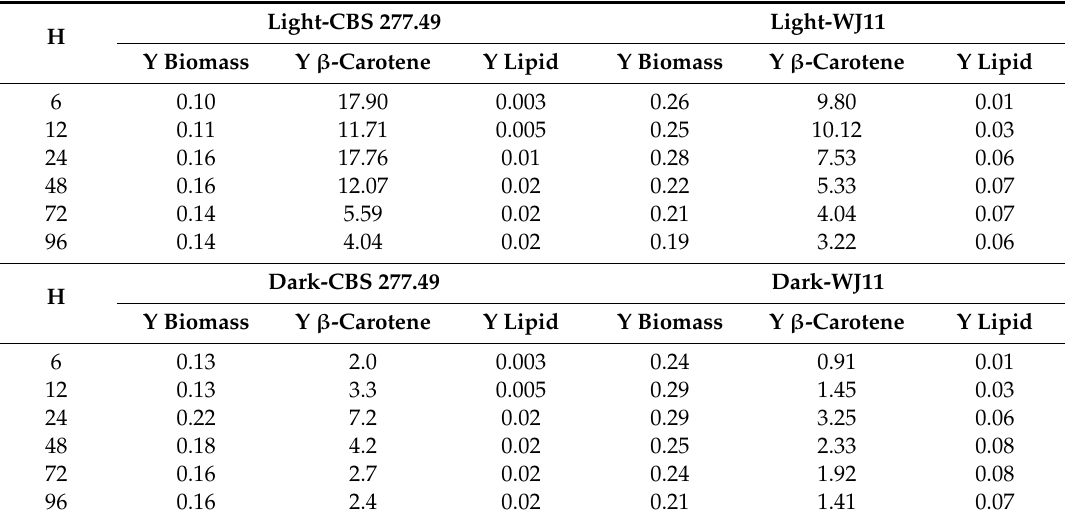
Table 1. Determination of yield of biomass, β -carotene and lipid production by CBS 277.49 and WJ11 under Light condition and Dark